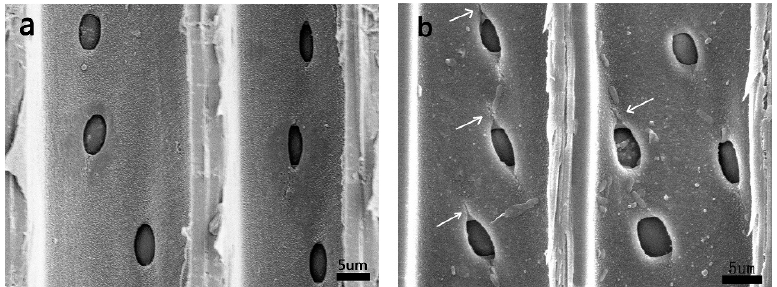
Figure 3. SEM micrographs of cross ‐ field pit region in low ‐ intensity MW ‐ treated sample:( a ) Control, ( b )low ‐ intensity MW ‐ treated sample.